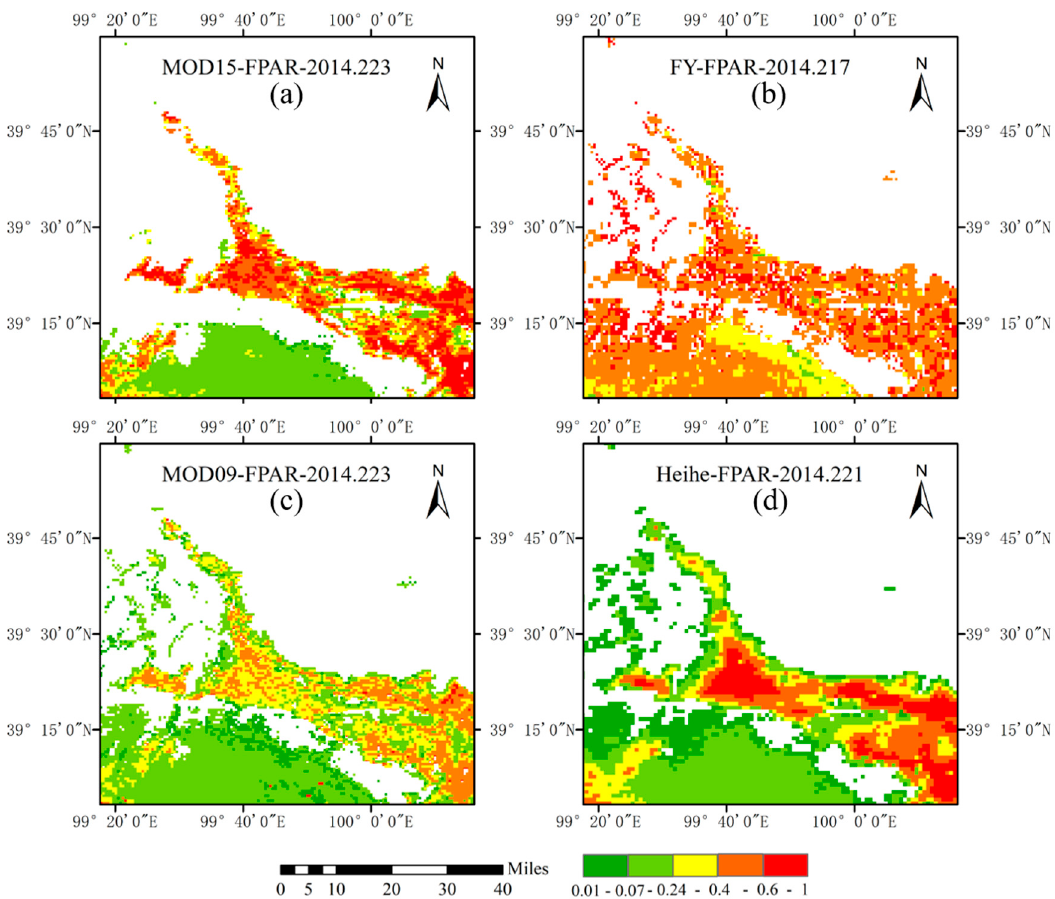
Figure 3. Comparison of the FPAR inversion results and FPAR products in the Heihe research area; ( a ) and ( b ) are the inversion of FPARs from the MOD09 and FY-3C data, respectively; ( c ) and ( d ) are the Moderate Resolution Imaging Spectro Radiometer (MODIS) FPAR products and Heihe products, respectively.